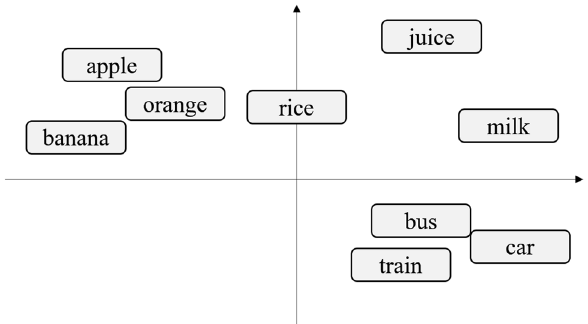
Fig. 10 Illustration of word similarity